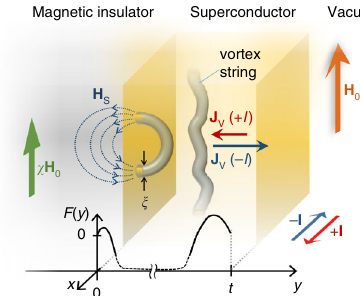
Fig. 1 Nonreciprocity in a system with topological objects in an asymmetric external environment. A superconductor with vortex strings close to a magnetic insulator with susceptibility χ is placed in an external magnetic fi eld H 0 . Vortex strings are depicted as normal cores in the superconducting condensate, with a characteristic diameter proportional to the superconducting coherence length ξ . Stray magnetic fi elds H S emanate from vortex strings nucleating at the superconductor surfaces. The difference in the nucleation energy F for vortex strings at the interface with the magnetic insulator ( y = 0) and the vacuum ( y = t ) leads to a nonreciprocity in the vortex fl ow J V when driving the vortex strings with an electric current ±